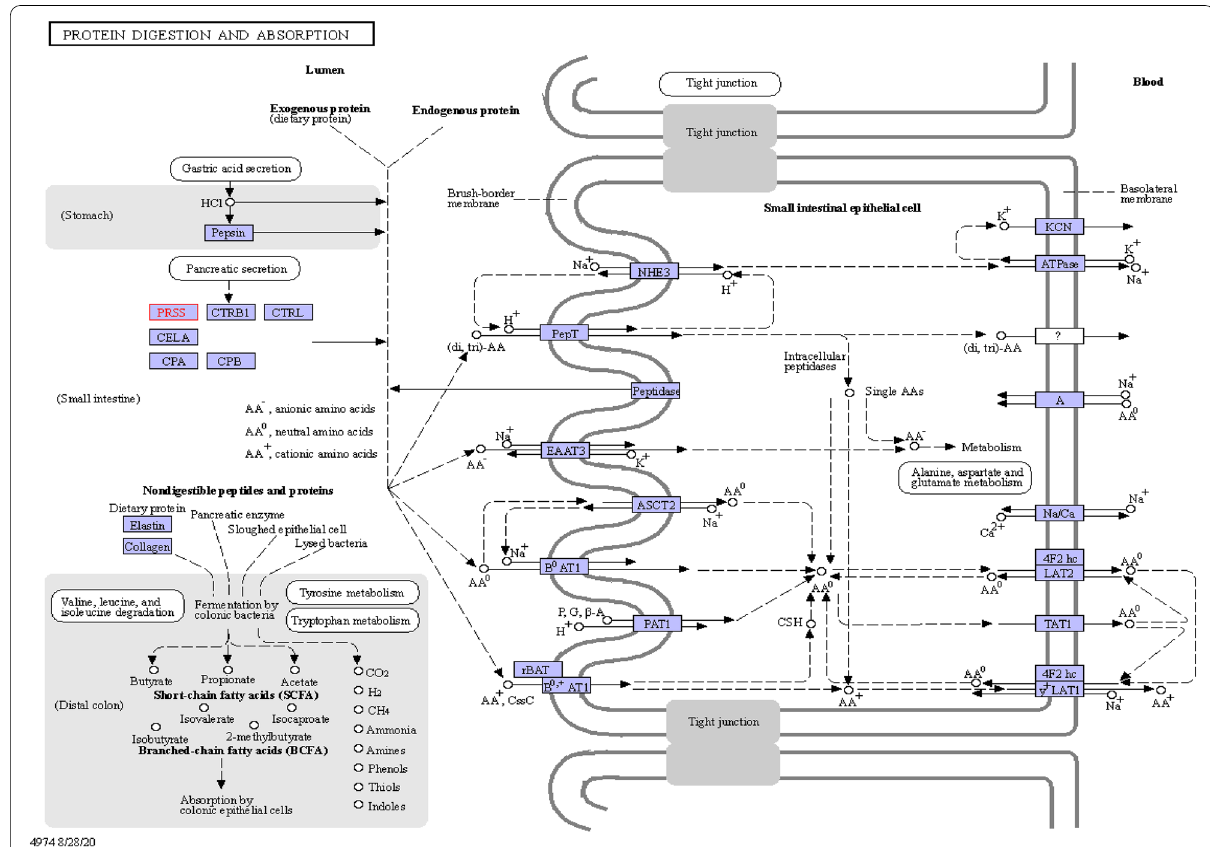
Fig. 1 Metabolic pathway of trypsin (EC 3.4.21.4) (synonym of cocoonase) in protein digestion and absorption (KEGG database at http://